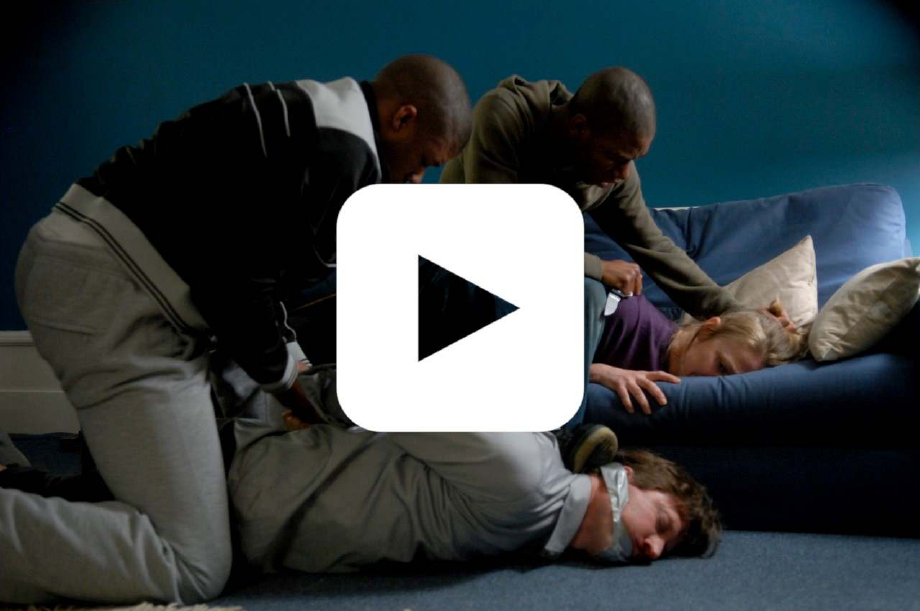
Figure 2. Cherry Tree Lane